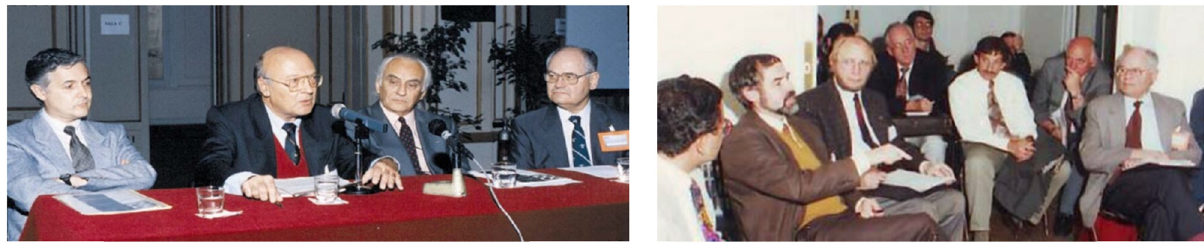
Figure 2: Opening session and Working Group discussion at the SIRGAS meeting, La Plata, Argentina, 1994.